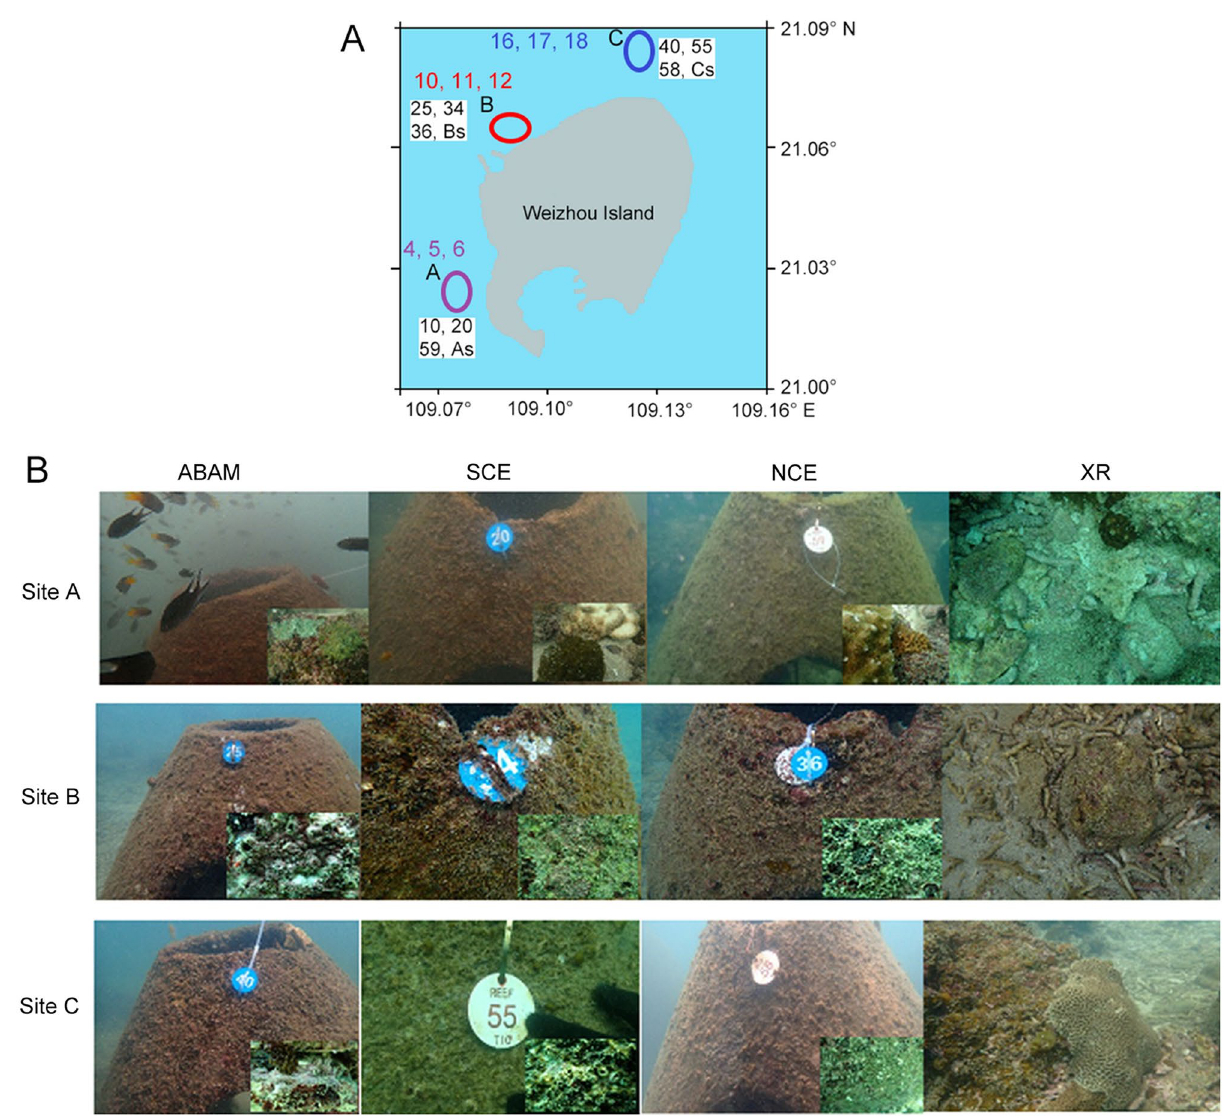
Figure 7. ( A ) A map of Weizhou Island created using Photopea online program (https:// www. photo pea. com/). The unfilled circles illustrate position of the three chosen sites, A, B and C covering the 9 stations 4, 5, 6, 10, 11, 12, 16, 17, 18. One model of ABRs is placed in each of the indicated stations. Position of deployment and samples from natural reef (XR group) per station are indicated in the white boxes. Purple circle represents site A, station 5 (covering models’ number 10, 20, 59, As), red circle represents site B, station 11 (covering models’ number 25, 34, 36, Bs) and blue circle represents site C, station 17 (covering models’ number 40, 55, 58, Cs). ( B ) A sample of pictures taken during sampling process from both the surface of ABRs and XR from the three sites, credit to Amro For Beta diversity, the Partial least squares Discriminant Analysis (PLS-DA) ordination was used to detect the difference in the microbial community patterns between the ABRs with different treatments and natural reef samples (XR) from the three selected localities over the three seasons (Fig. 4A). The Marked differences in taxonomic composition among the XR, from different localities were highlighted. The PLS-DA analysis also reveals a gradual change in natural community composition across the three localities A, B and C (Fig. 4A). It also showed similar microbial community structures in ABAM and SCE samples and tended to group together in contrast to NCE control and XR samples. A PCA was performed according to the ASVs level to examine the correlation among the microbial com- munity structures on different ABRs and in XR samples collected from the three selected localities over three seasons (Fig. 4B). PCA illustrated that all the samples could be separated based on the phylum abundance data set (Fig. 4C).